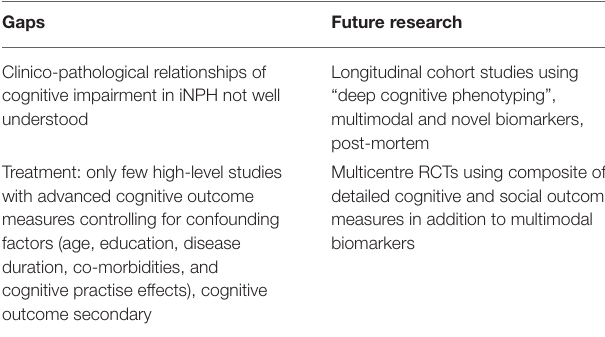
TABLE 1 | The pathological basis of cognitive impairment in iNPH and the treatment response to shunting of cognitive impairment in iNPH requires further